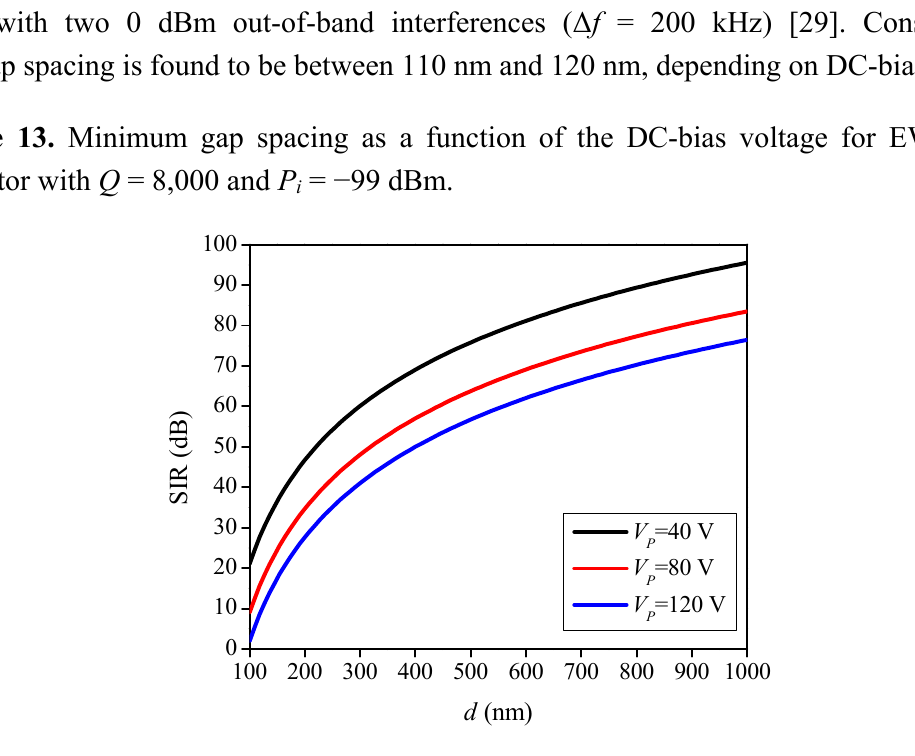
= − 99 dBm ( a ) P = − 49 dBm; i int